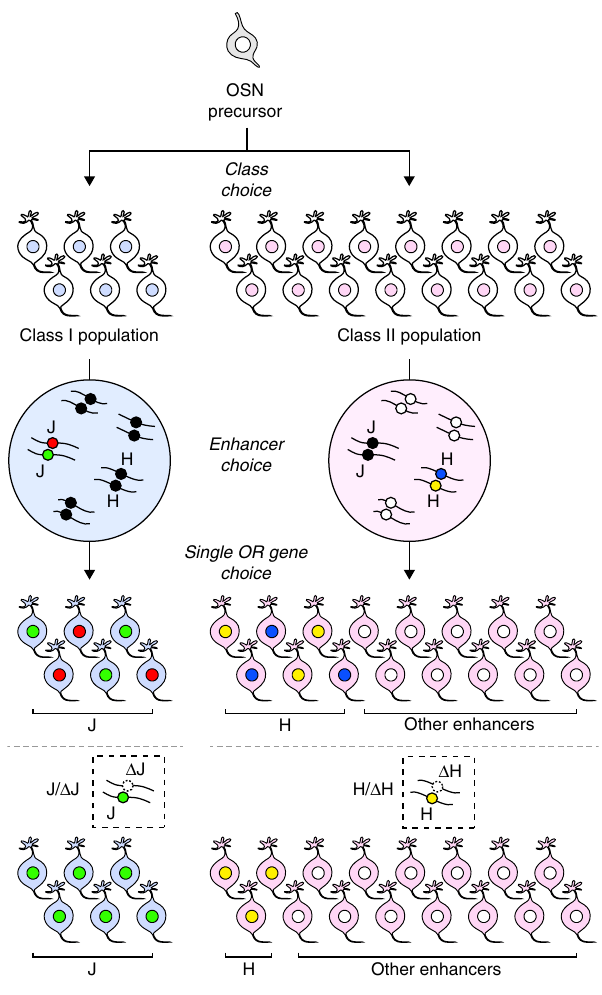
Fig. 7 Model for the enhancer-dependent process of the singular OR gene expression. OSNs are fated to express a single OR gene from the repertoire of class I or class II genes to produce fi xed populations of class I ( blue ) and class II OSNs ( magenta ). Subsequently, a functional OR enhancer is chosen according to the OSN fate to open up local chromatin structure to orchestrate the fi rst step of OR gene choice. Class I OSNs activate one enhancer allele of the J element ( green or red circle ) or of a limited number of enhancer elements. By contrast, class II OSNs select one element from the class II enhancer repertoire spread over most chromosomes ( white circle , H element is colored in yellow or blue ). The selected enhancer element chooses one functional OR allele to express. In Δ J heterozygous mutation, the intact J element allele ( green ) is activated to complement the Δ J allele to fi ll in the class I OSN population. In class II enhancer (e.g., Δ H) heterozygous mutation, an intact element is selected randomly from the class II enhancer repertoire spread over chromosomes. In consequence, the expression of the H element linked OR genes are reduced to ~